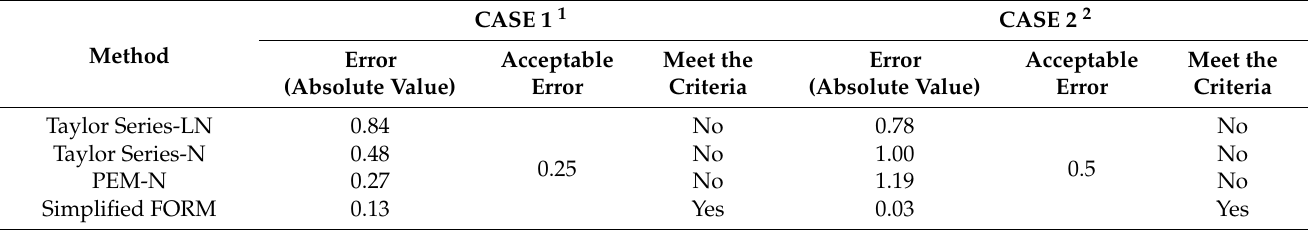
Table 9. Reliability methods suitability assessment in the case of stability of embankments [1] according to the proposed criteria.